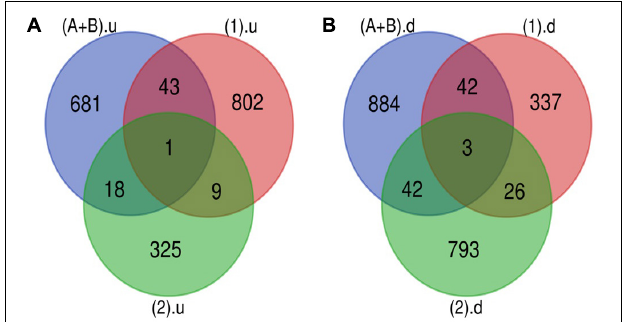
FIGURE 2 | Genes specific for DR. (A) Up-regulated genes: total 743 (681 + 18 + 1 + 43) up-regulated genes are present in DR out of which 681 are uniquely present in DR cases. (B) Down-regulated genes: total 971 (884 + 42 + 3 + 42) down-regulated genes are present in DR out of which 884 are uniquely present in DR cases (A+B).u: (up-regulated genes in inactive and active FVM of DR); (1).u: (up-regulated genes in DN); (2).u: (up-regulated genes in DFU); (A+B).d: (down-regulated genes in inactive and active FVM of DR); (1).d: (down-regulated genes in DN); (2).d: (down-regulated genes in DFU).